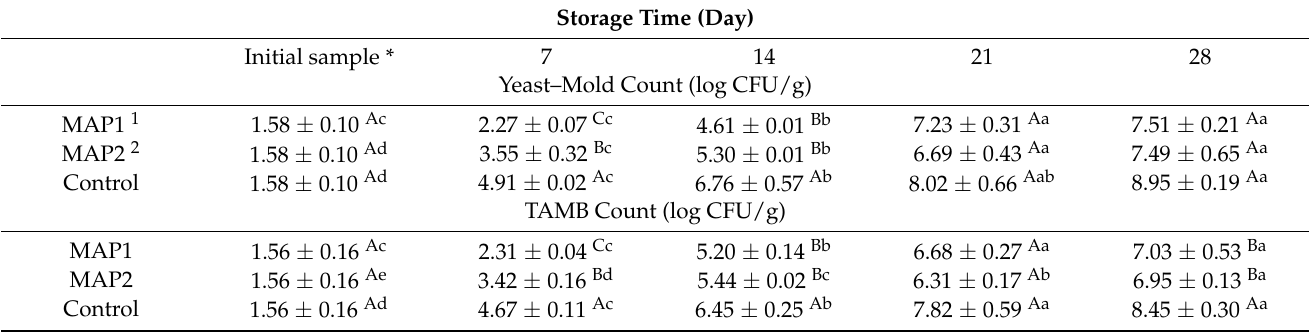
Table 3. Yeast–Mold counts, and total aerobic mesophilic bacteria (TAMB) counts of CC samples. Storage Time